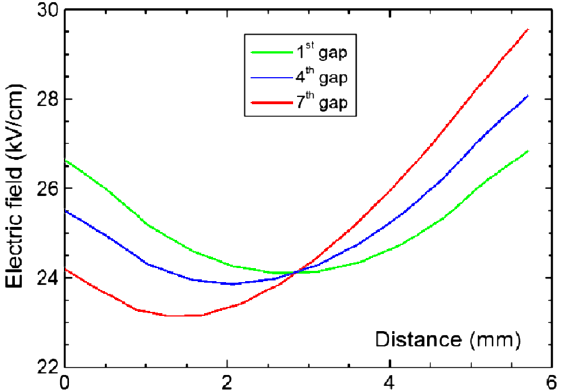
FIG. 3. Field distribution in the interelectrode gaps for the standard switch configuration at equal distribution of potentials on the electrodes.